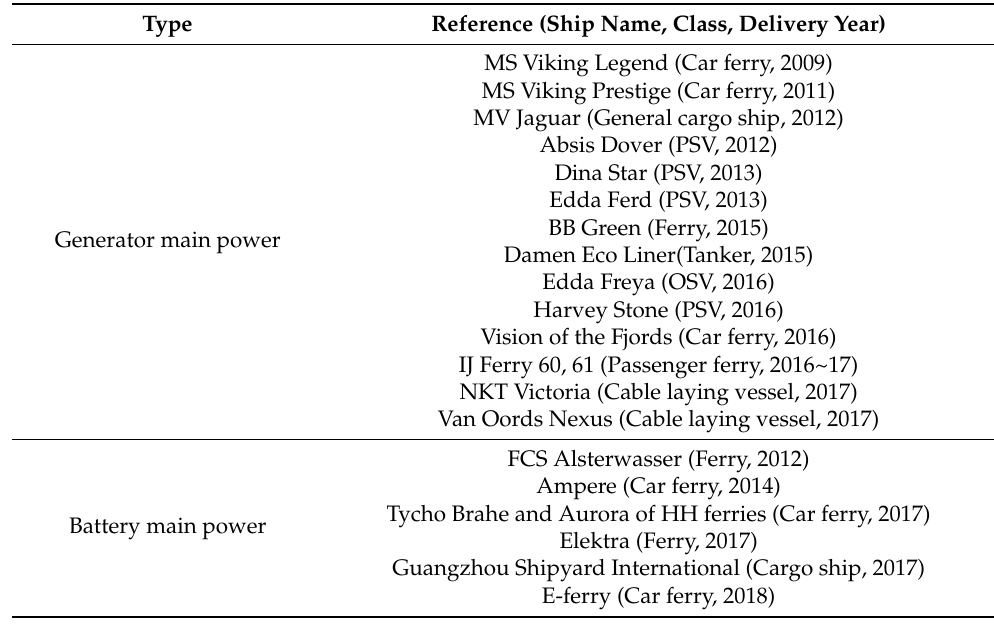
Table 1. References of the DC-gird system in ships [Kim et al., 2020].